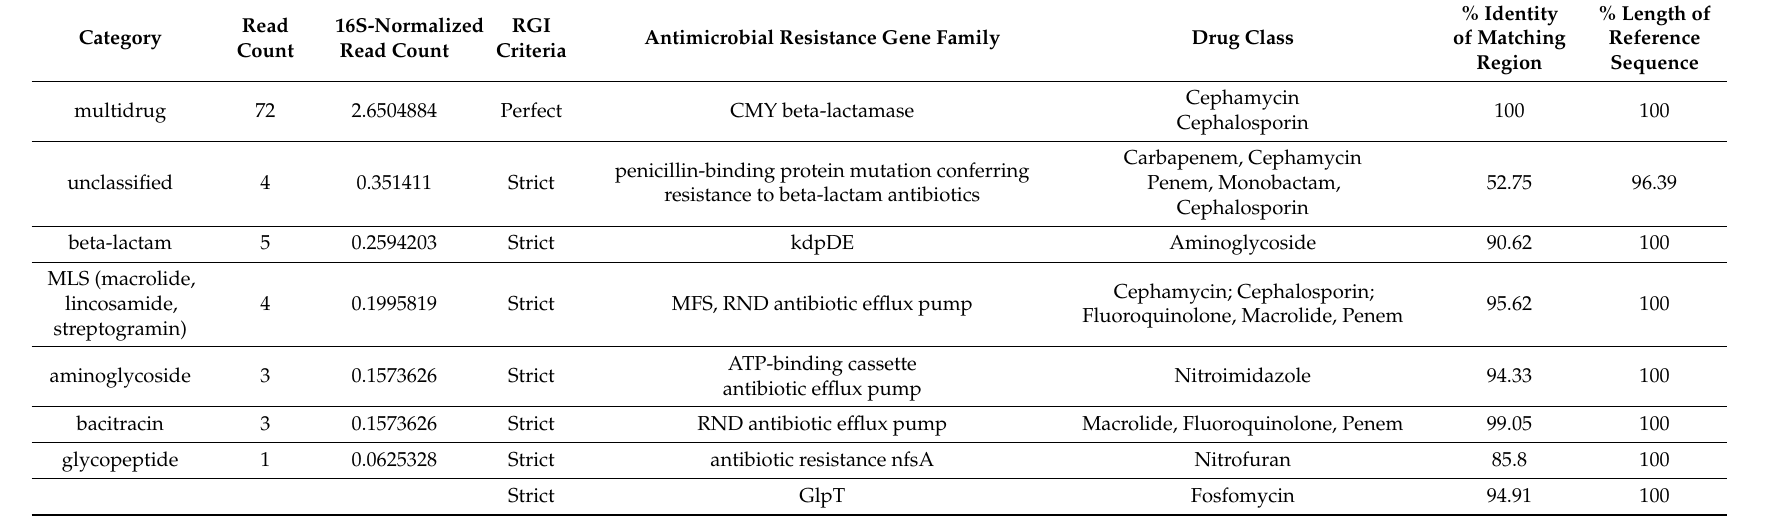
Table 3. Resistance Gene Identifier (RGI) analysis for C.